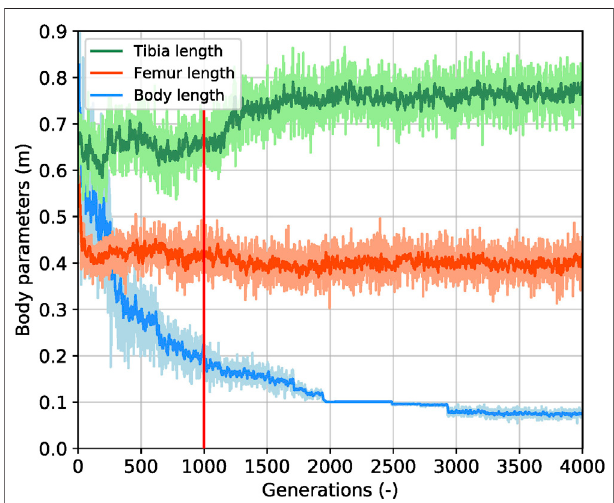
FIGURE 7 | Parameters for the body length and the leg length over generations of the fast bipedal winner in the performance-based scaffolded case. The green curve and the orange curve are the tibia length and the femur length parameters, respectively. Their ranges are from 0.05 to 0.9 m, and they are set to mutate freely. The light-blue curve is the body length parameter which is forced to decrease based on the current performance observed, and the original range is from 0.05 to 1.8 m. Here, we squeeze the display range to 0.9 and use a smoothness function to draw the data clearly, which is conducive to investigate the changes of body parameters. The red line labels the place where the tibia length starts gradually increasing with the support of the body length.